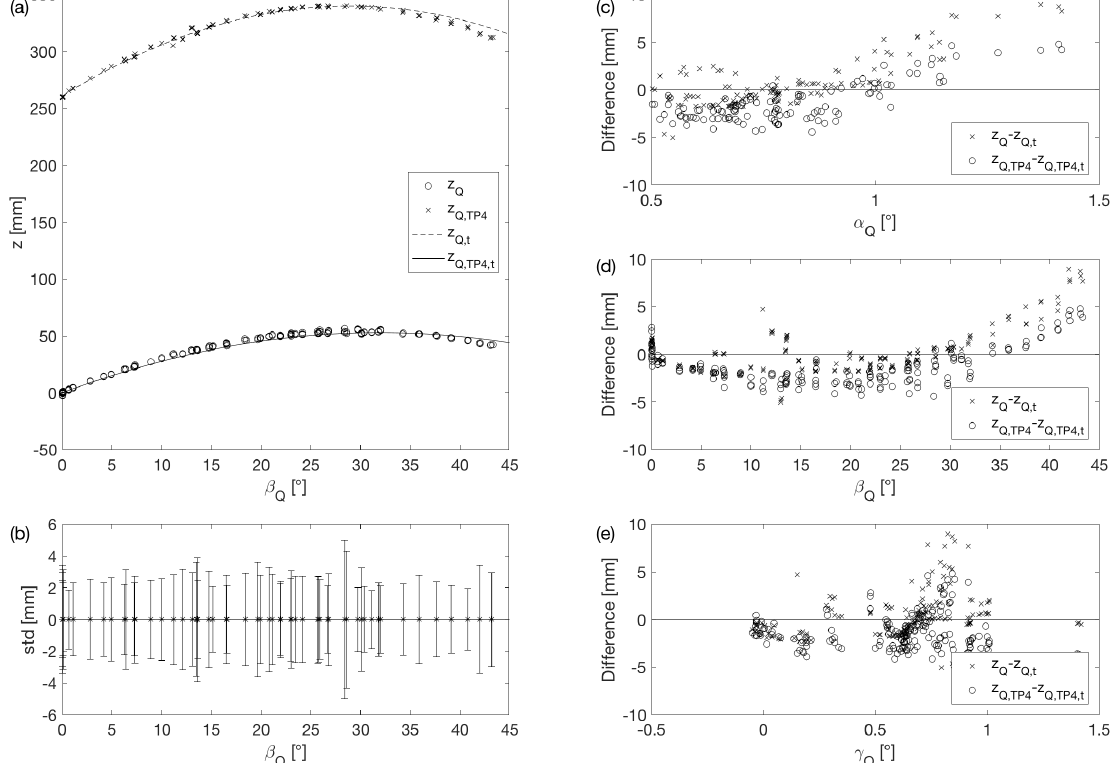
Figure 5. Influence of variable pitch angle β on the floating markers—( a ) comparison of the theoretical with the measured z -coordinate of the reference point TP 4 and the free surface; ( b ) standard deviation of the measured balls; ( c – e ) absolute difference of the z -coordinate in relation to all three rotation